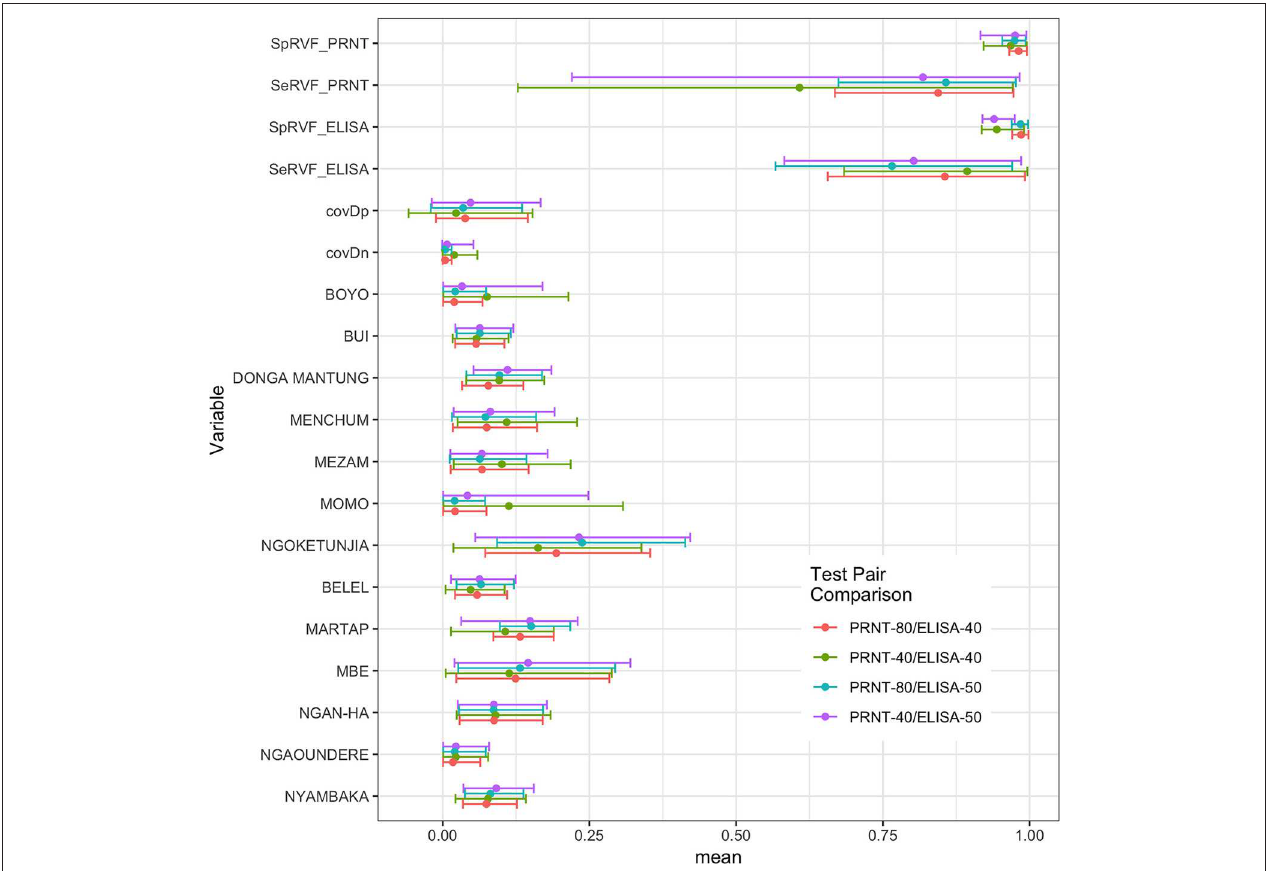
FIGURE 2 | Bayesian posterior means and 95% BCI for the two tests and their covariances (covDn, covDp) and the 13 prevalences for the subpopulations using the Hui-Walter NGS model allowing for conditional dependence between tests. The four test/cut-off combinations are presented together for